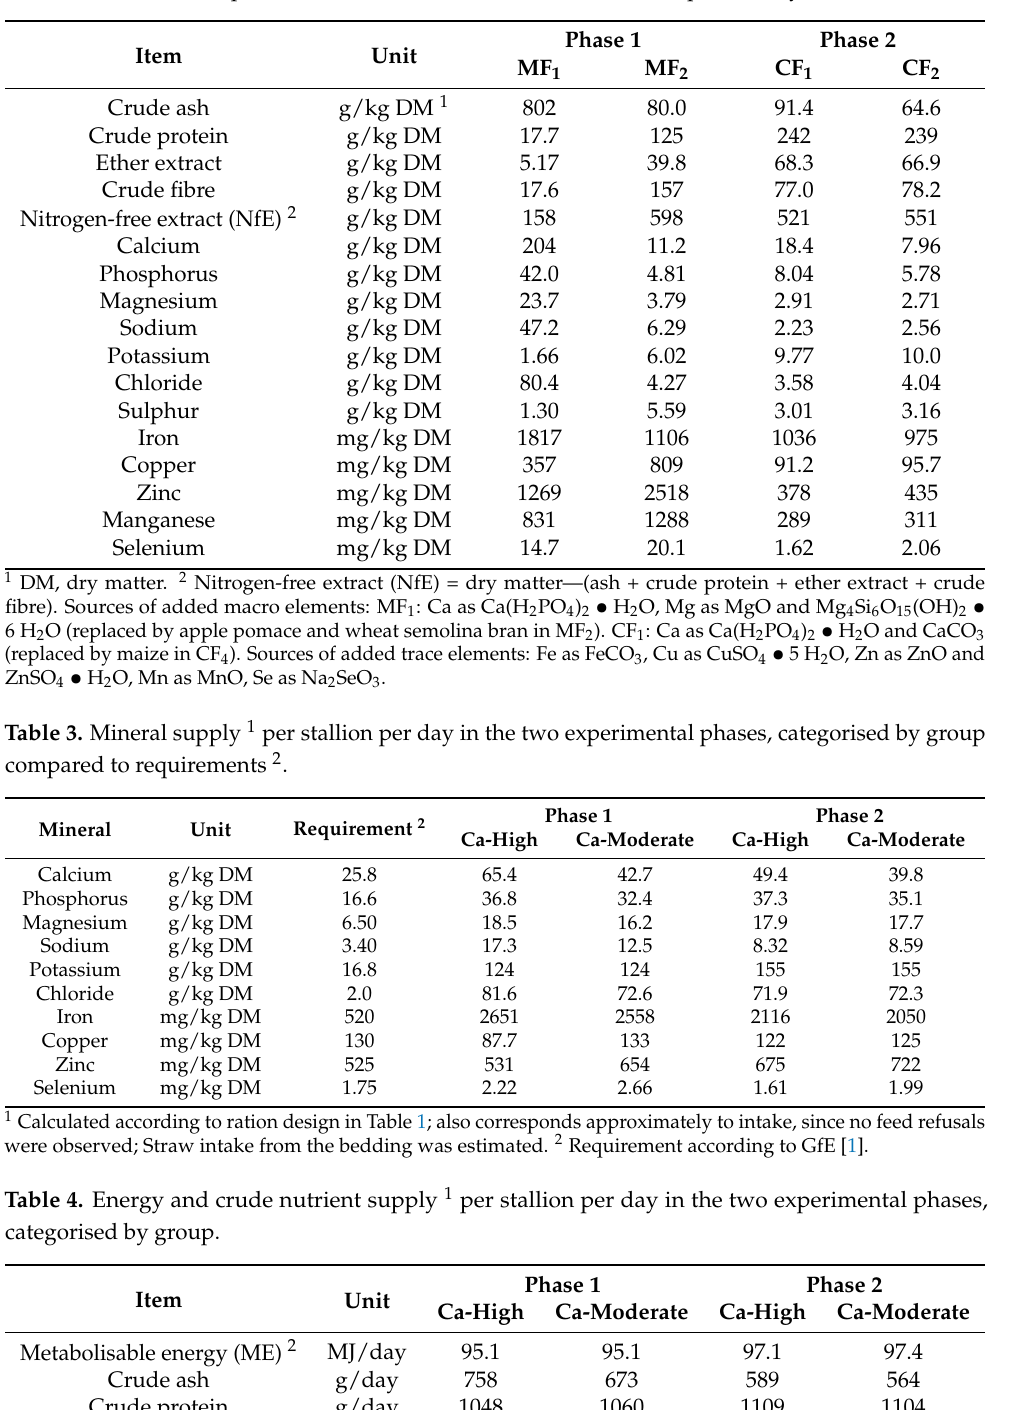
Table 2. Chemical composition of mineral feeds (MF 1 , MF 2 ) and complementary feeds (CF 1 , CF 2 ).